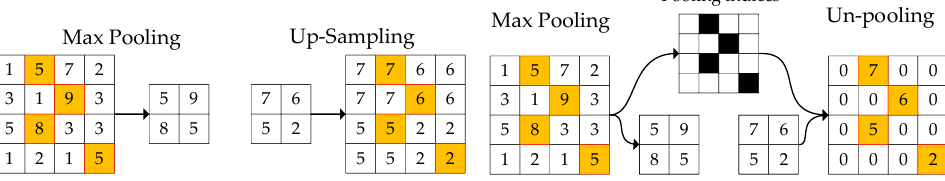
Figure 9. Decoded results of the pure Gaussian noise as deep features; the inputs are the same as those in Figure 6.